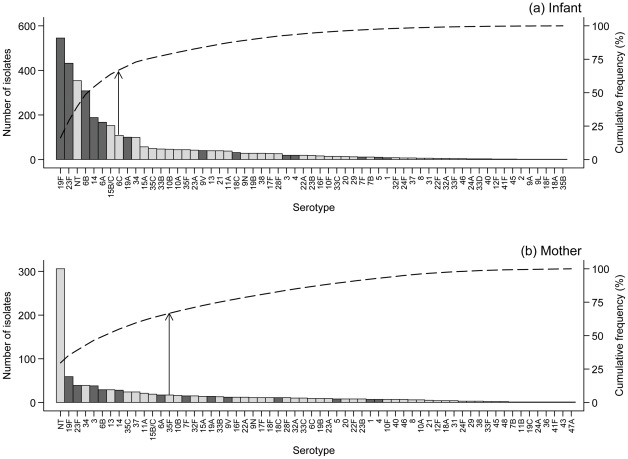
Pneumococcal serotype distribution in (a) infants and (b) mothers.The bars indicate the number of isolates of each serotype and the dashed lines indicate the cumulative frequency (cumulative frequency of 67% is indicated by the vertical arrows). Dark gray bars highlight PCV13 serotypes.